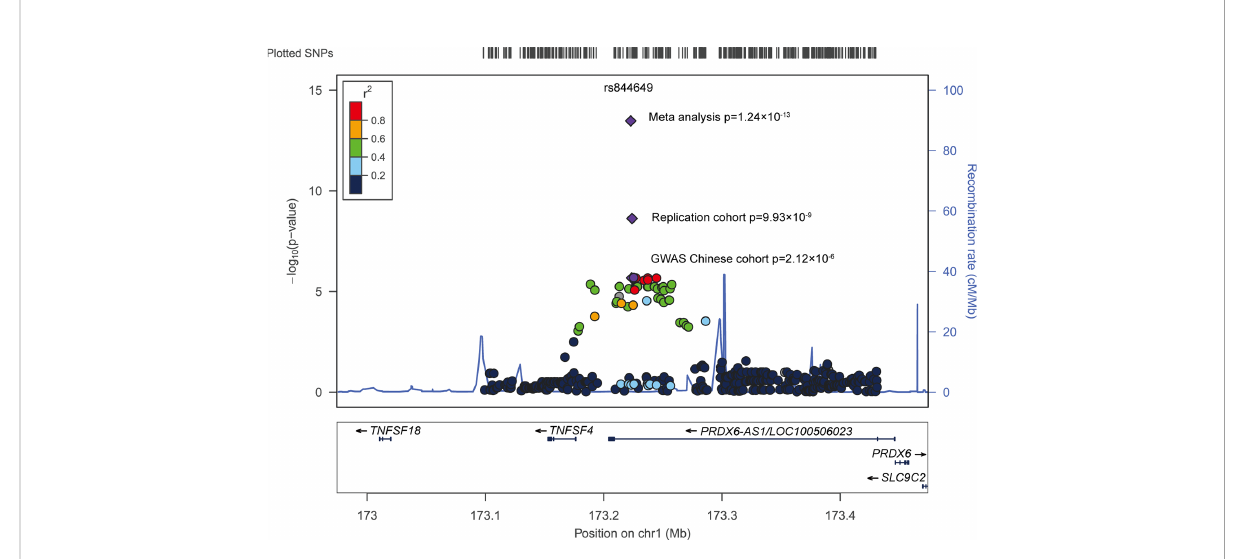
FIGURE 1 Regional association plots around rs844649 PRDX6-AS1